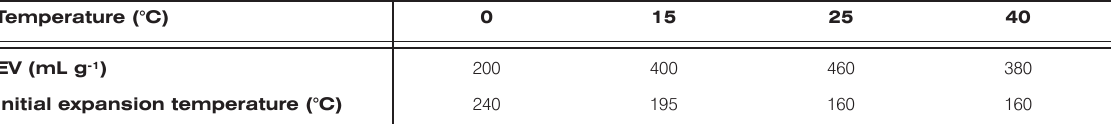
Table 5. Influence of reaction temperature on initial expansion temperature and